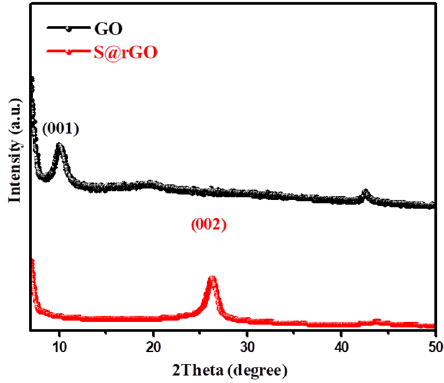
Figure 1. XRD of GO (black data) and S@rGO (red data).